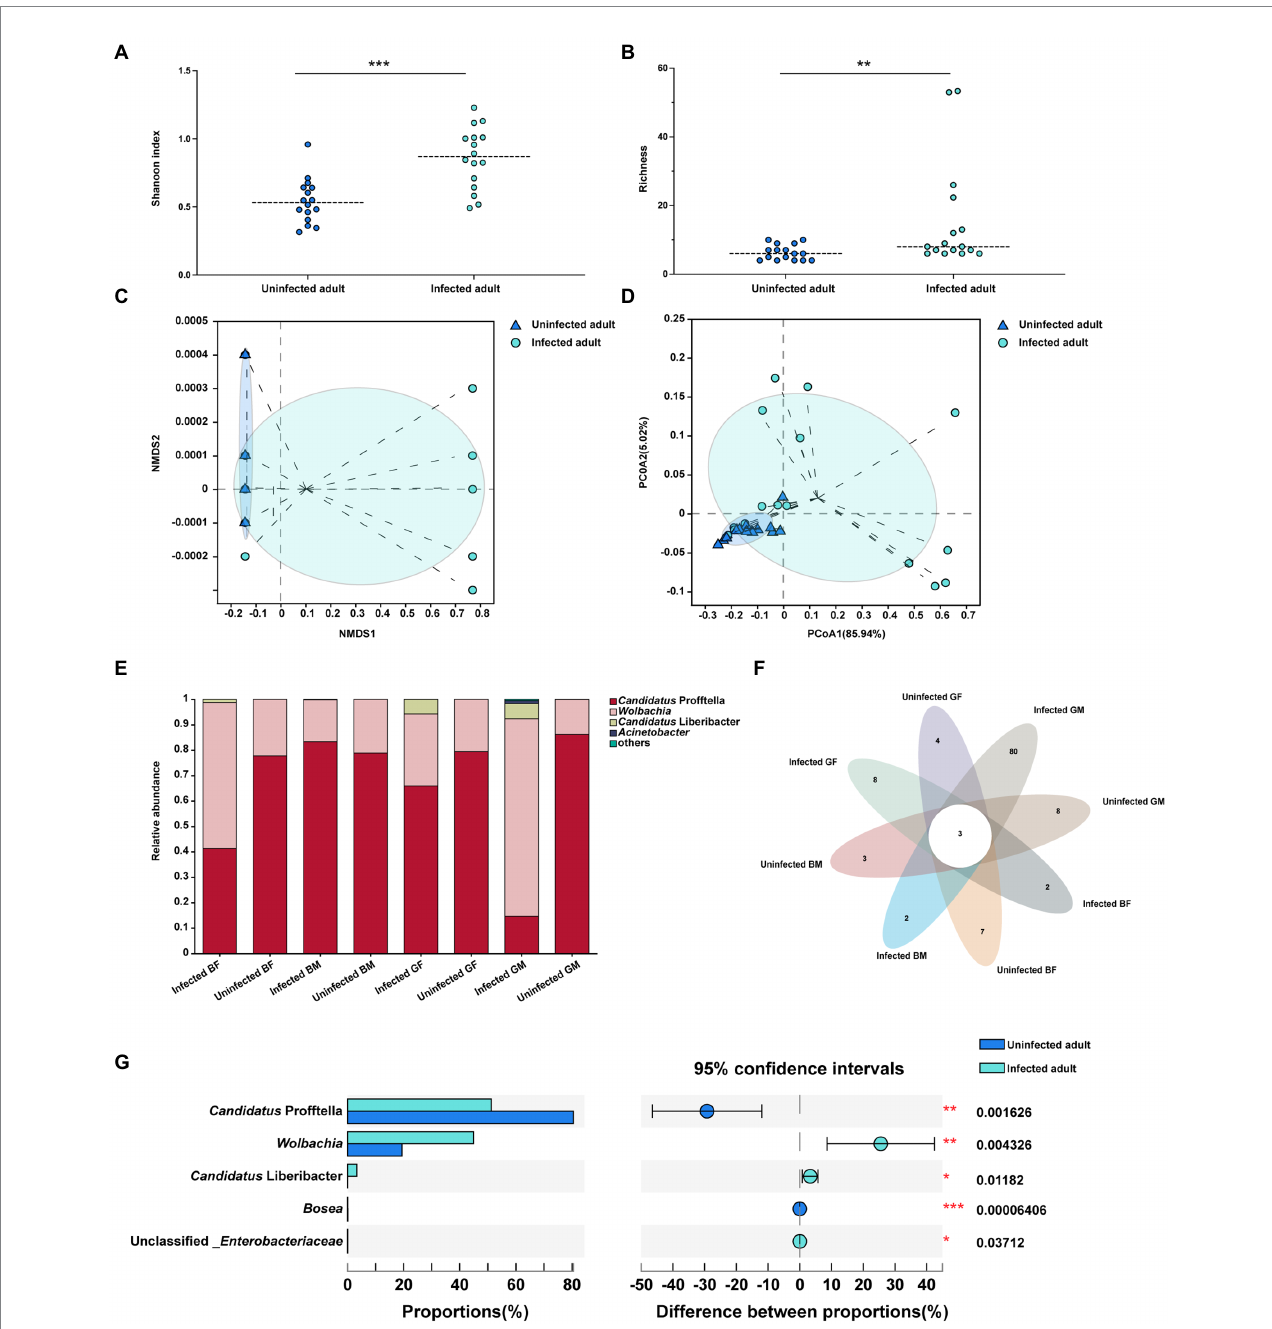
FIGURE 2 The alpha and beta level diversity analysis of different color morphs and genders of C Las uninfected and infected ACP adults. (A) Shannon diversity indices showed the bacterial community diversity of C Las uninfected and infected ACP adults. (B) Chaol indices showed the bacterial community richness of C Las uninfected and infected ACP adults. (C) Non-metric multidimensional scaling (NMDS) analysis. (D) Principal coordinates analysis (PCoA). (E) The bar plot of the bacterial proportion of C Las uninfected and infected ACP adults. (F) Core-Pan ASV presents the common and unique ASV of all samples in the petal diagram. (G) The bacterial proportion in C Las uninfected and infected ACP adults. The data were analyzed by the analysis of variance (ANOVA)-followed by Tukey’s test, comparison of Shannon diversity and Chaol indices and the difference of the bacterial proportions were by non-parametric analysis (*, p < 0.05; **, p < 0.01; ***, p < 0.001). BF, blue-female; BM, blue-male; GM, gray-male; GF,